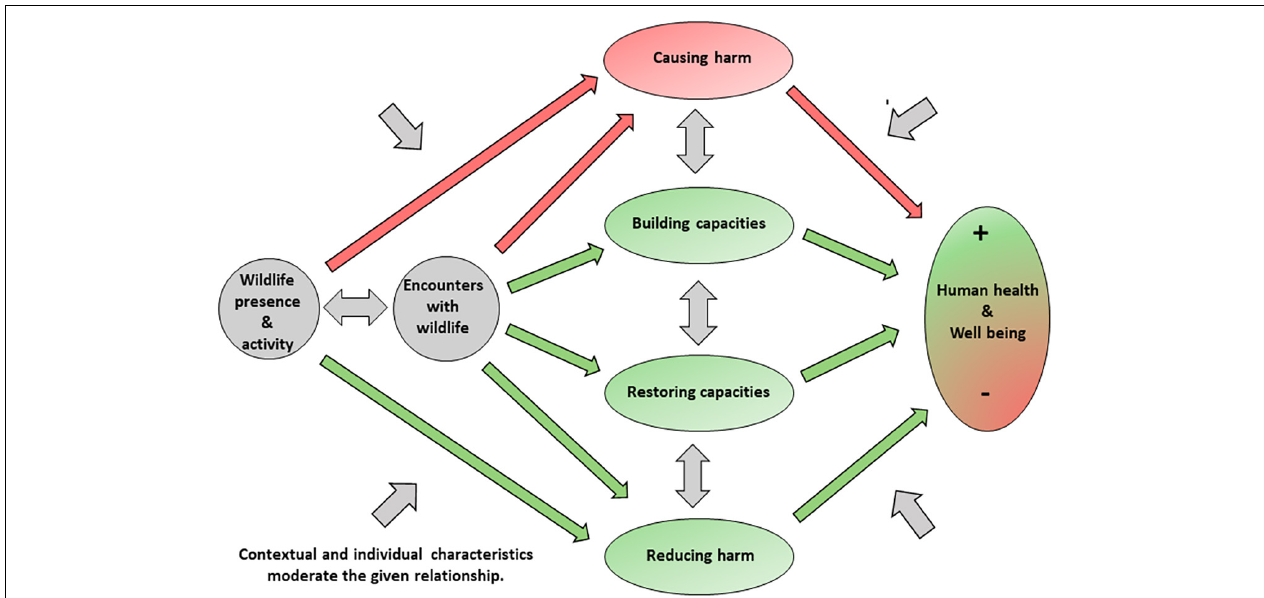
FIGURE 1 | A general conceptual model with domains of pathways through which the presence and activity of wildlife can come to have both positive and negative effects on human health and well-being. Some pathways do not run through encounters with wildlife, indicating that they may have effects by means outside the awareness of the people involved. Pathways in any one domain may influence and/or be influenced by pathways in any another domain, but for simplicity in the presentation only relationships between adjacent domains are shown. The vertical ordering of the pathway domains also serves to simplify the presentation; it does not imply a necessary logical order. As indicated by the gray arrows, the strength and direction of effects transmitted via pathways in any of the domains may depend on features of the context (e.g., everyday life in a rural residence versus a guided wildlife safari in an exotic location) and of the individual (e.g., age, gender, emotional disposition, work in animal husbandry versus wildlife conservation, and hunting experience). Adapted from Hartig et al. (2014); Markevych et al. (2017) and Marselle et al.